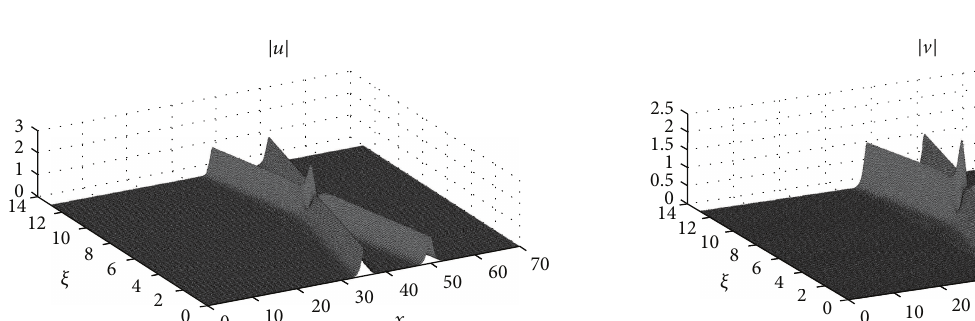
Figure 10: Effect of the inhomogeneous coefficient 𝑒(𝑥) on the shape of the vector soliton. Here 𝛿 = 0 , 𝛼 = 1.5 , 𝜎 1 = 0.5 , 𝜎 2 = −0.5 , 𝐾 = 0.5 , = 35 , 𝑎(𝑥) = 𝑐(𝑥) = sech 𝑝 (𝑥 − 𝑥 𝑥 0 Pointed line: 𝐴 = 3 . Dashed line: 𝐴 = 10 .